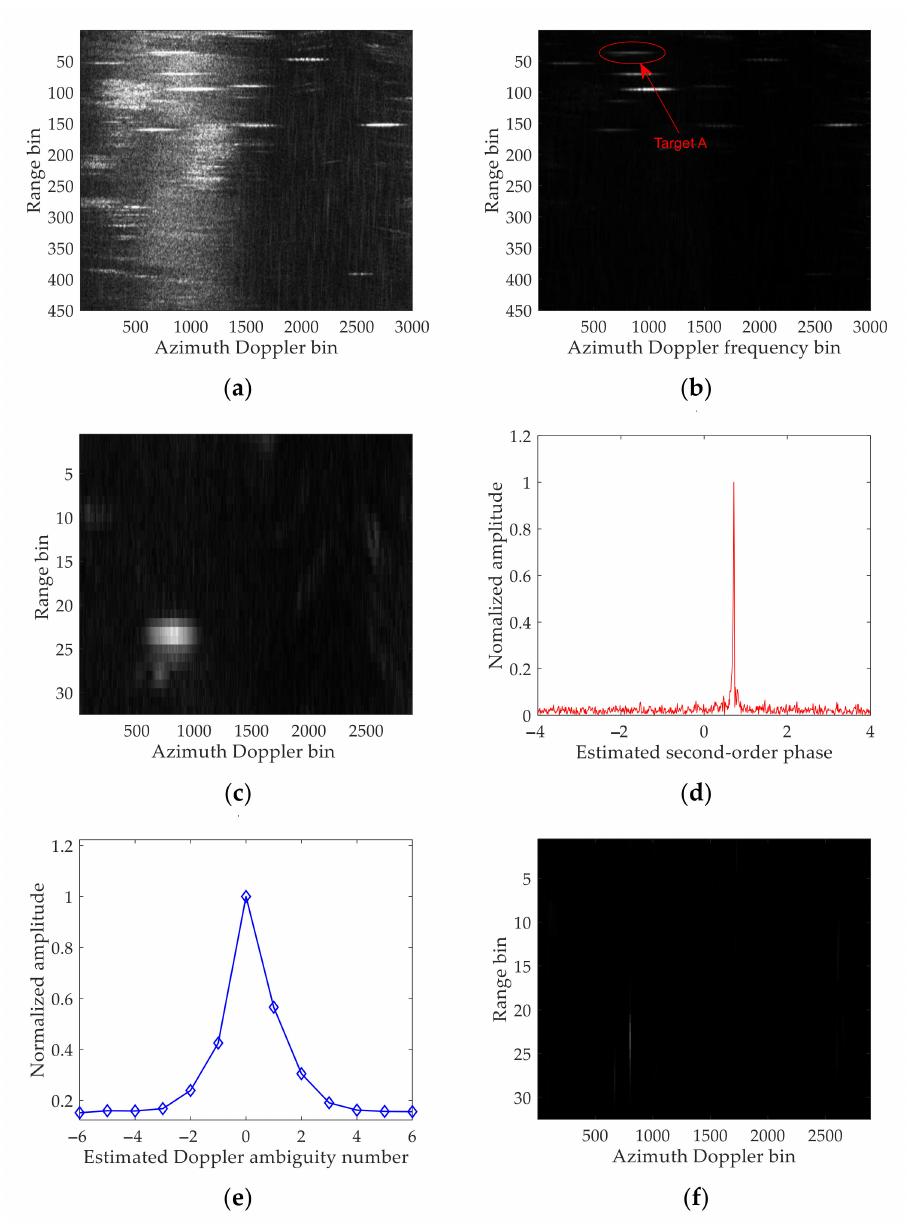
Figure 6. Airborne real data processing results: ( a ) Range compression result. ( b ) Clutter suppression result. ( c ) Focusing result by direct fast Fourier transform (FFT). ( d ) Estimated second-order phase coefficient. ( e ) Estimated result of Doppler ambiguity number. ( f ) Final refocused result by proposed